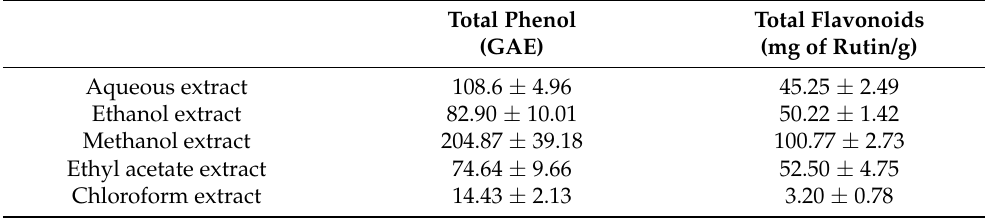
Table 1. Total phenol contents and total flavonoids of aqueous and ethanol extracts of L. angustifolia .